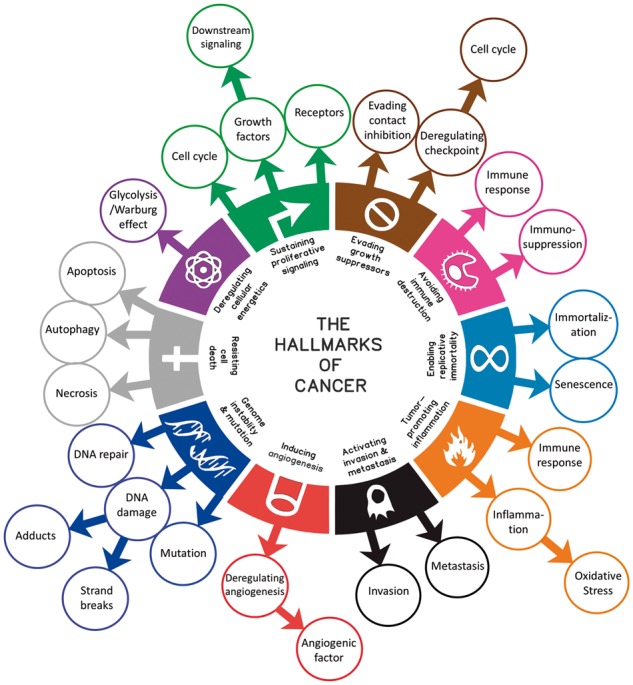
The Hallmarks of Cancer taxonomy. The inner circle represents the main ten cancer hallmarks and the outer circles indicate the cellular processes associated with each cancer hallmark as described in (Hanahan and Weinberg, 2011)